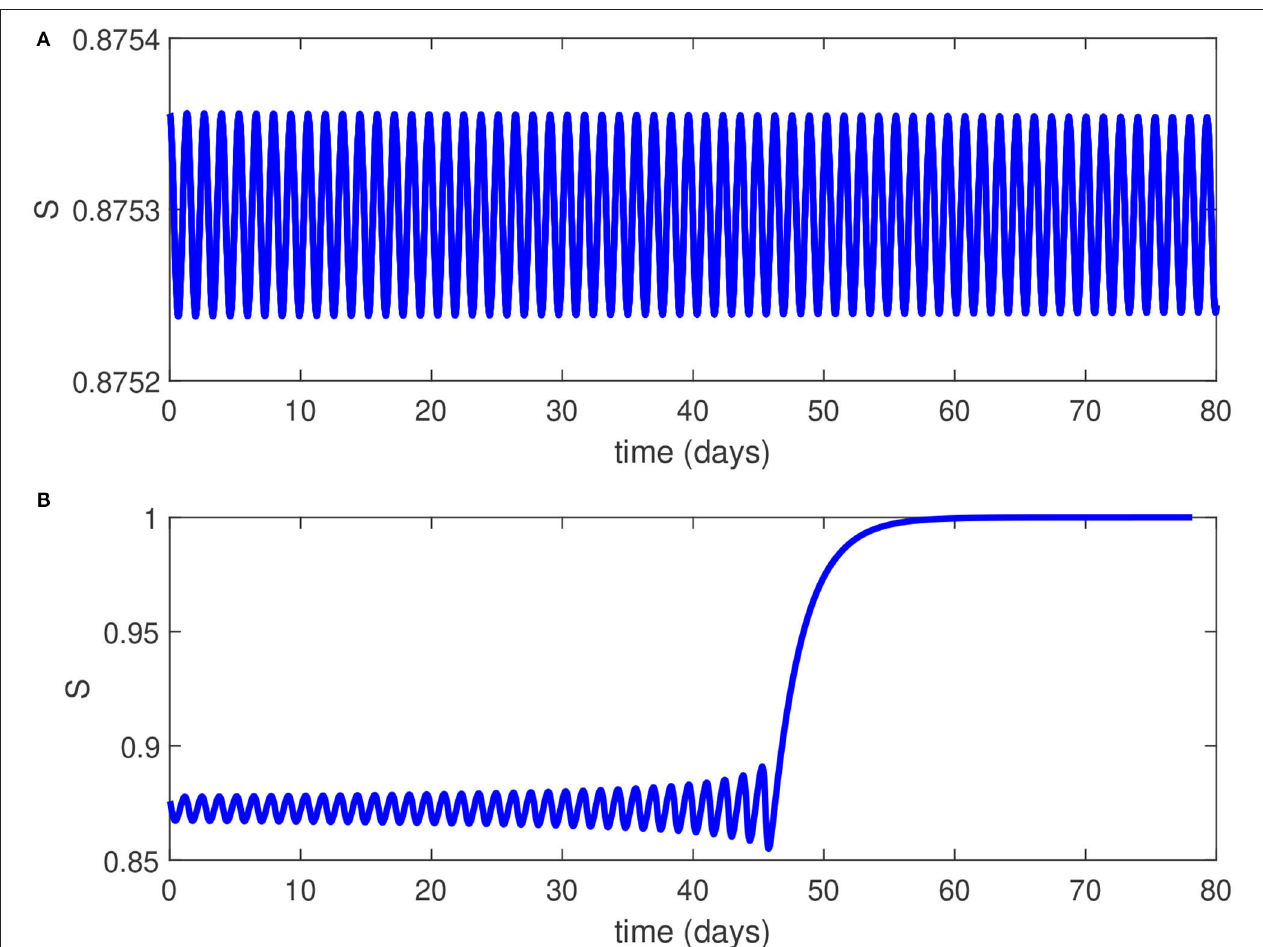
FIGURE 4 | (A) Time trace close to the Hopf point R 0 = 0.896 of Figure 3 . (B) Time trace for R 0 = 0.899 of Figure 3 showing unstable oscillations growing in magnitude until they collide with the static branch.